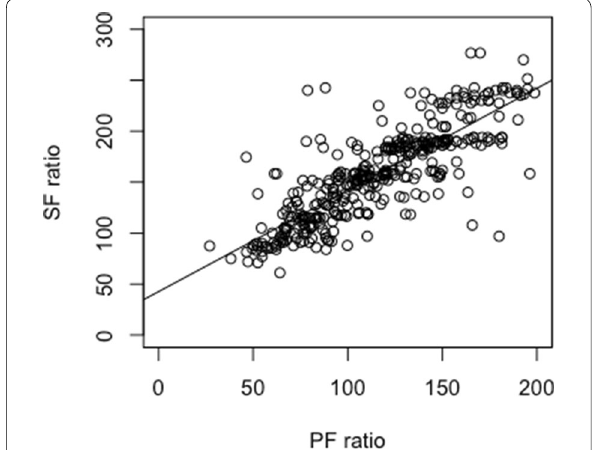
Fig. 2 Scatterplot of SPO 2 /FiO 2 versus PaO 2 /FiO 2 at initial ARDS diagnosis. The line represents the best‑fit linear relationship: SpO 2